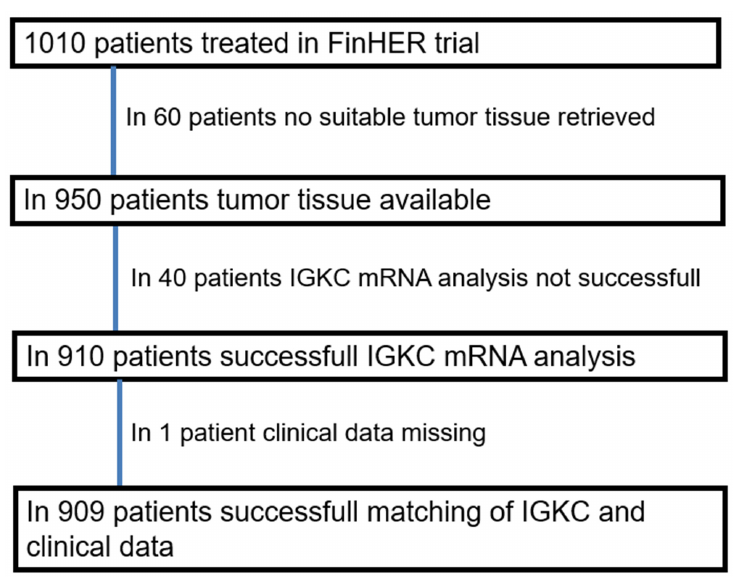
Figure 1. CONSORT diagram showing patient selection for the study. Table 1. Association of IGKC mRNA content in the tumor with clinicopathological characteristics.